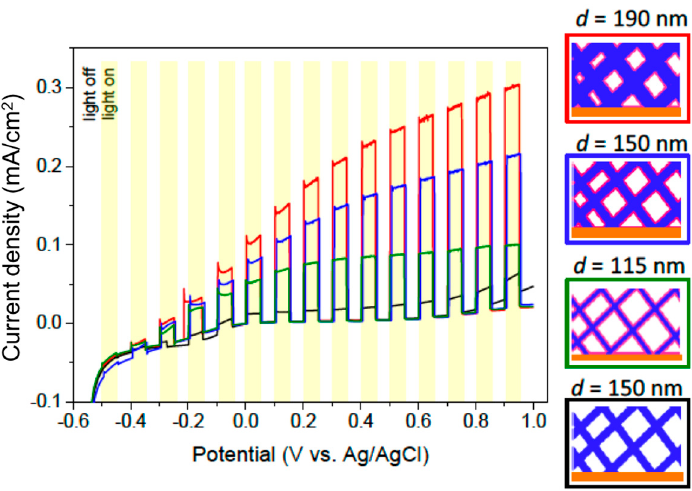
Figure 9. Linear sweep voltammograms measured under chopped light illumination for ZnO (black) and ZnO/TiO 2 nanowire networks with nanowire density 5 × 5 × 10 8 cm − 2 and wire diameters 115 nm (green), 150 nm (blue), and 190 nm (red). The 4 nm TiO 2 coating layer was prepared by ALD at 250 °C. Scan rate was 10 mV/s.